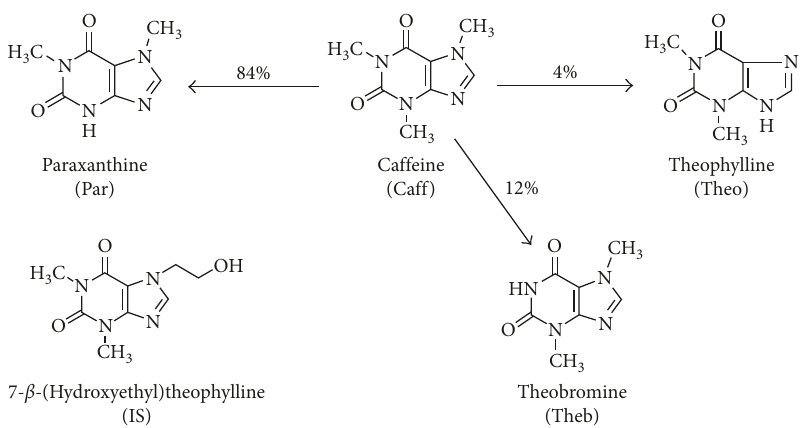
Figure 1: Caffeine and its major metabolites and internal standard